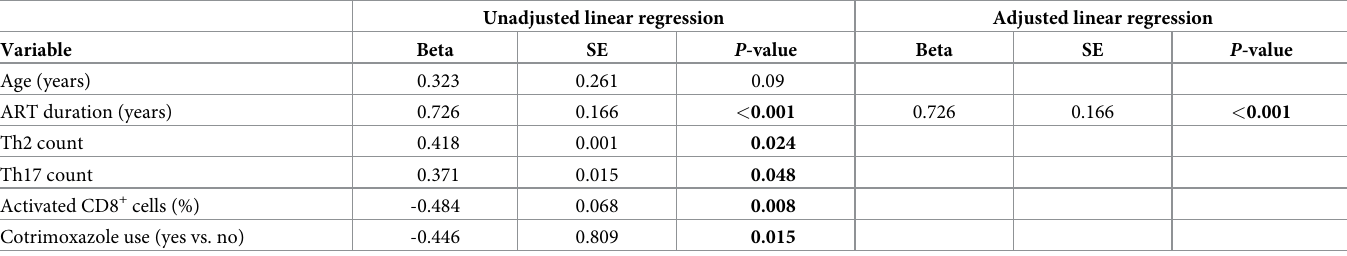
Table 2. Linear regression analysis of Clostridium perfringens with age, ART duration, immune status, and use of cotrimoxazole in the ART(+) group. Unadjusted linear